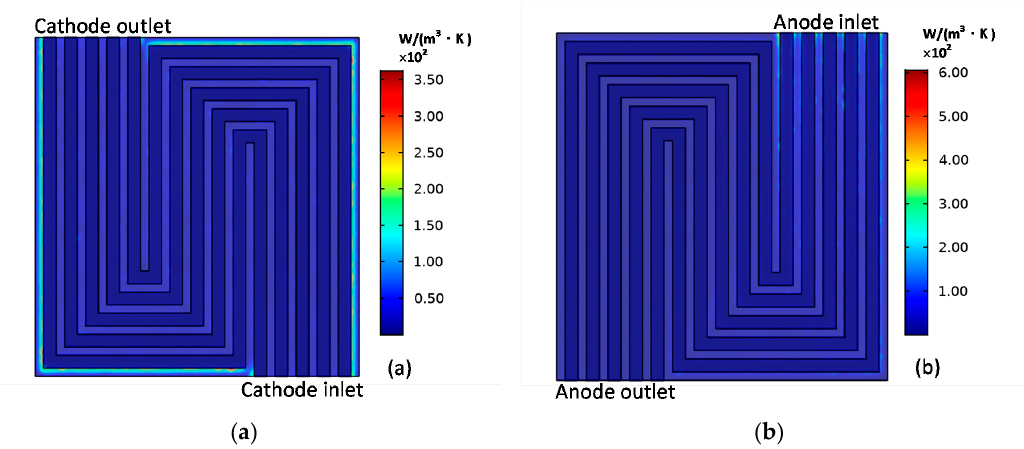
Figure 5. Cathode ( a ) entropy production and anode ( b ) entropy production caused by mass transfer.